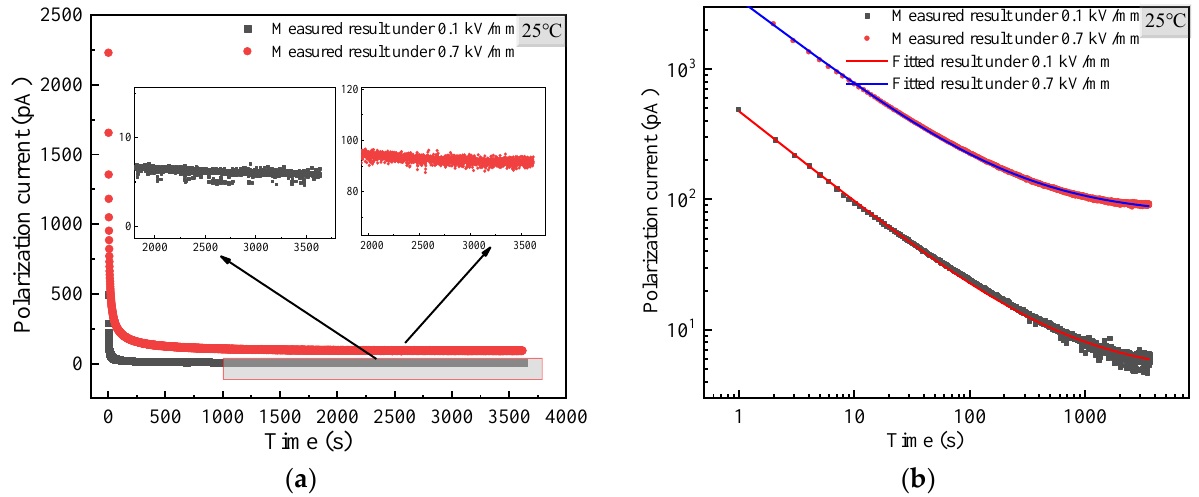
Figure 7. Current TDS of surface modified MgO powder at 25 °C. ( a ) Linear coordinate; ( b ) double logarithmic coordinate.